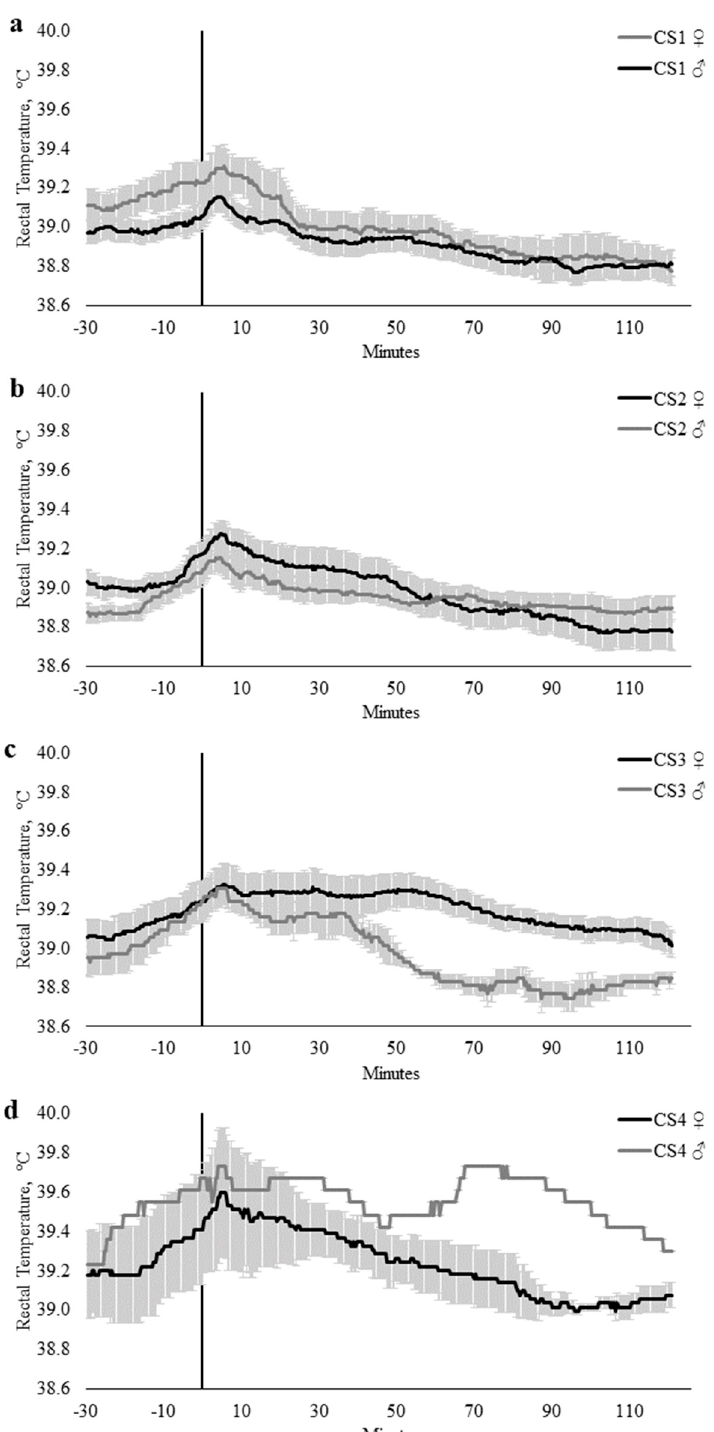
Figure 6. Twenty-seconds mean (±SEM) rectal temperature (T REC , °C) of heifers (gray line) and steers (black line) with crush scores of ( a ) 1 (CS1; n = 14; ♀ = 4, ♂ = 10); ( b ) 2 (CS2; n = 16; ♀ = 7, ♂ = 9); ( c ) 3 (CS3; n = 11; ♀ = 9, ♂ = 2); and ( d ) 4 (CS4; n = 4; ♀ = 3, ♂ = 1).